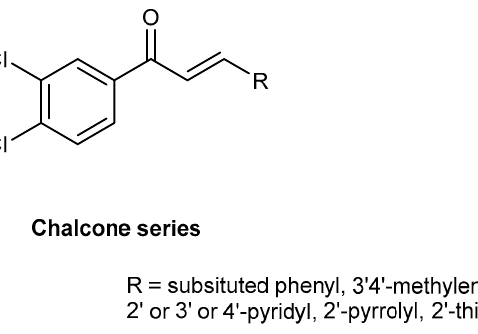
Figure 3. Newly designed chlorine containing chalcones and dihydropyrazole derivatives.